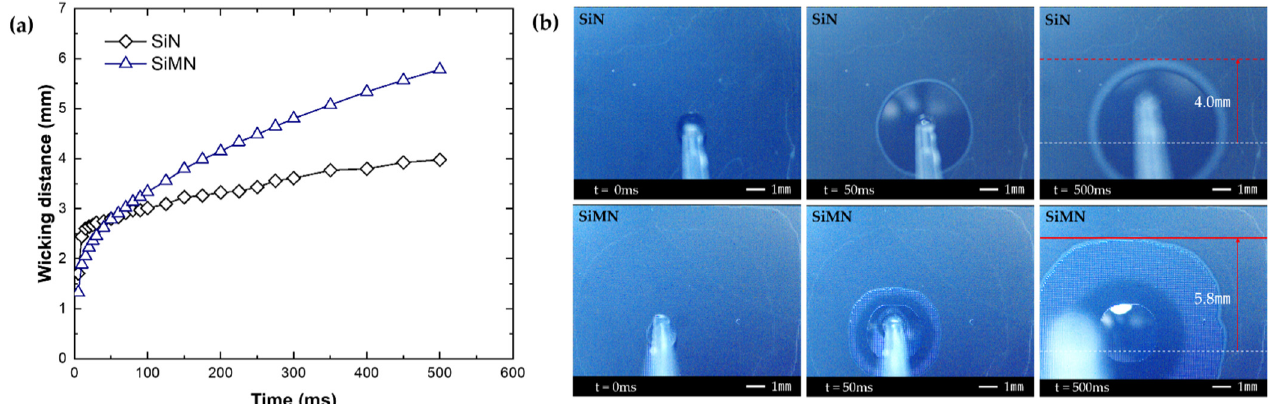
Figure 5. Capillary wicking test. ( a ) Wickability of the samples (Wicking distance—Time), ( b ) spreading images on SiN, SiN, SiMN.